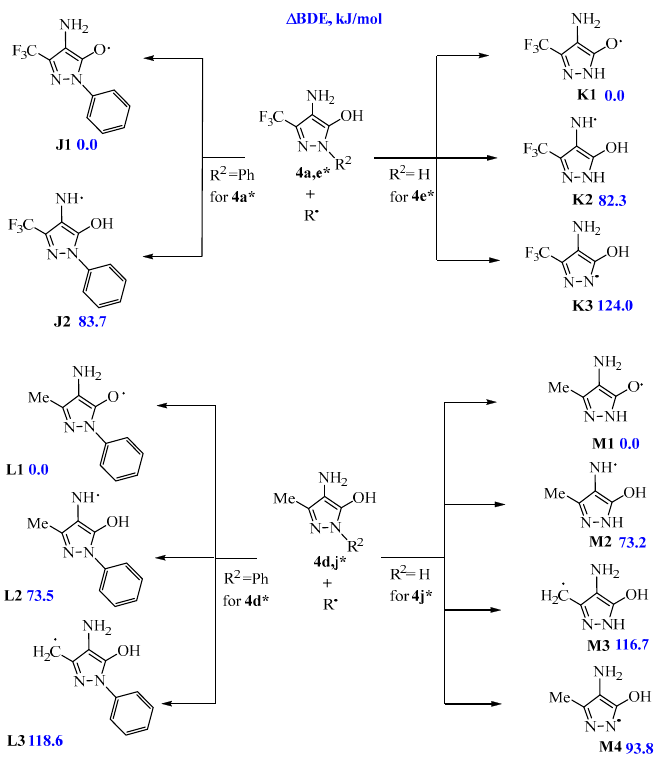
Scheme 3. The formation of possible radicals in the reactions of 4-aminopyrazolols 4a , d , e , j * (* conversions are given for 4-aminopyrazolols), with values of the difference in bond dissociation energies ( ∆ BDE, kJ/mol), which were evaluated in the approximation of the gas phase (B3LYP/cc- pVDZ method).